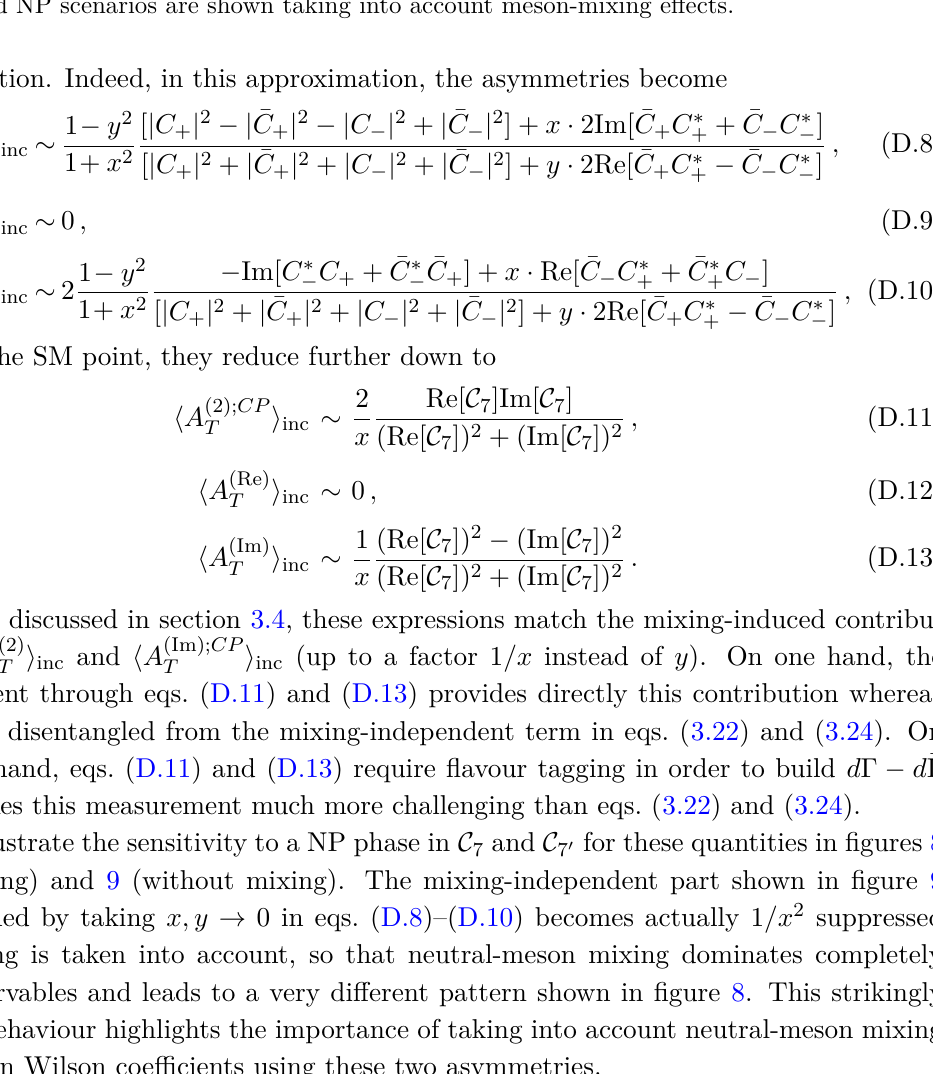
i inc and h A ( Im ) i inc in the bin q 2 ∈ [0 . 0008 , 0 . 257] GeV 2 . T T